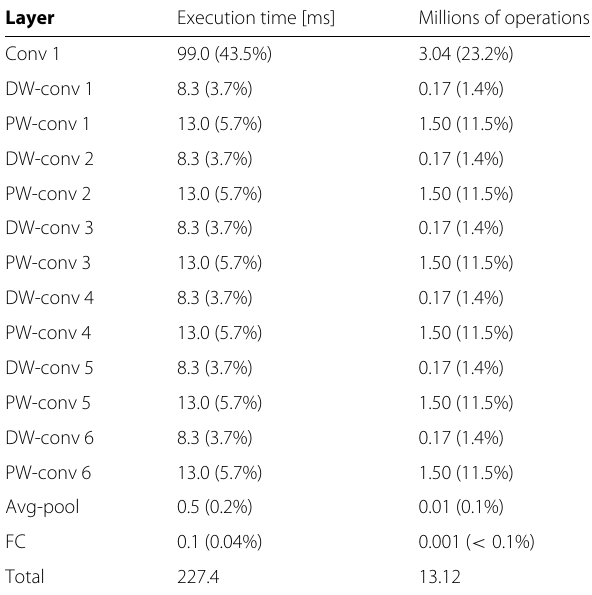
Table 6 Layer distribution of execution time and operations